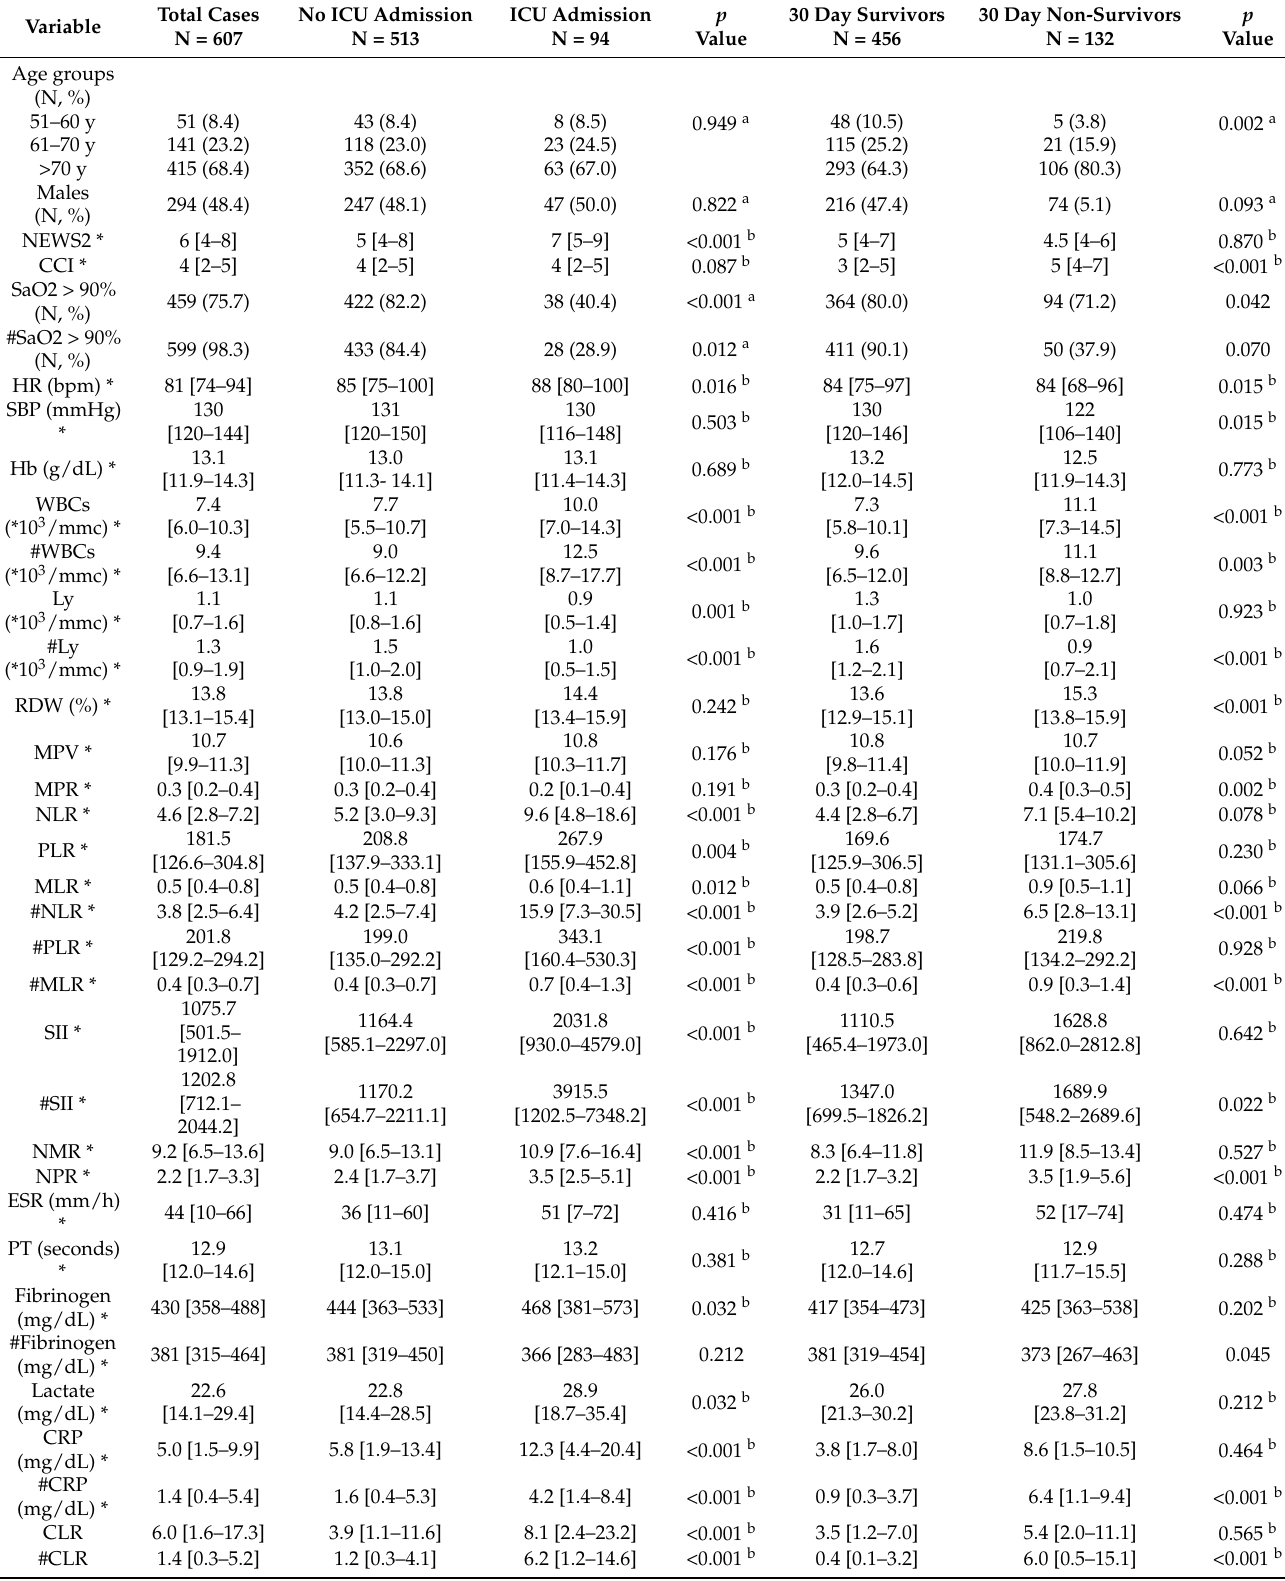
Table 1. Baseline characteristics of the cohort according to the main